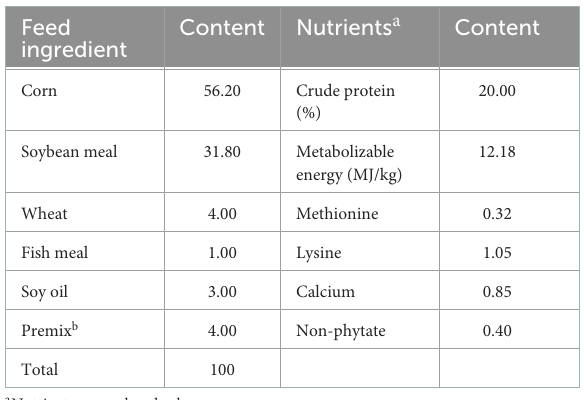
TABLE 1 Feed and nutrient composition of the experimental chicken diet (as-fed basis,